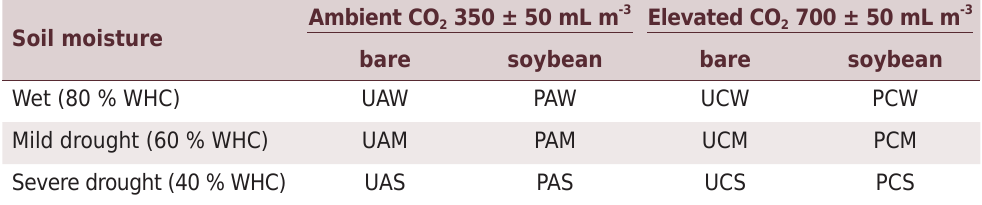
Severe drought (40 %